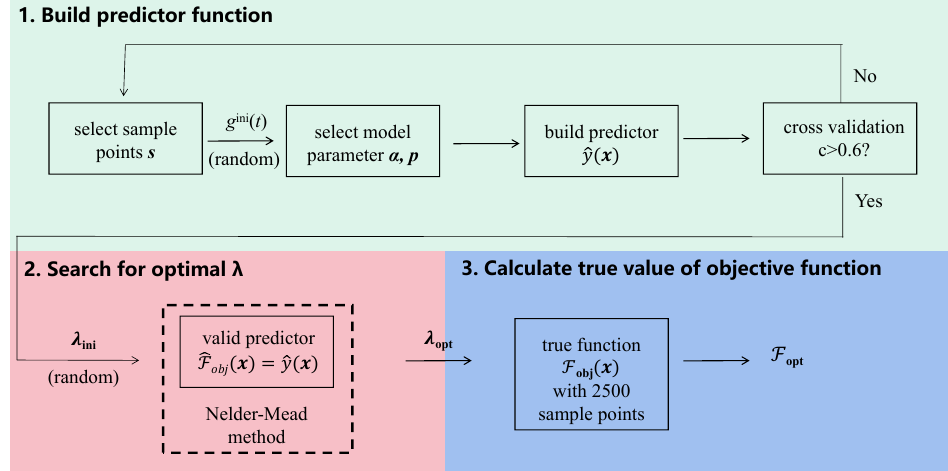
Figure 2. Process schematic of Bayesian-based optimization